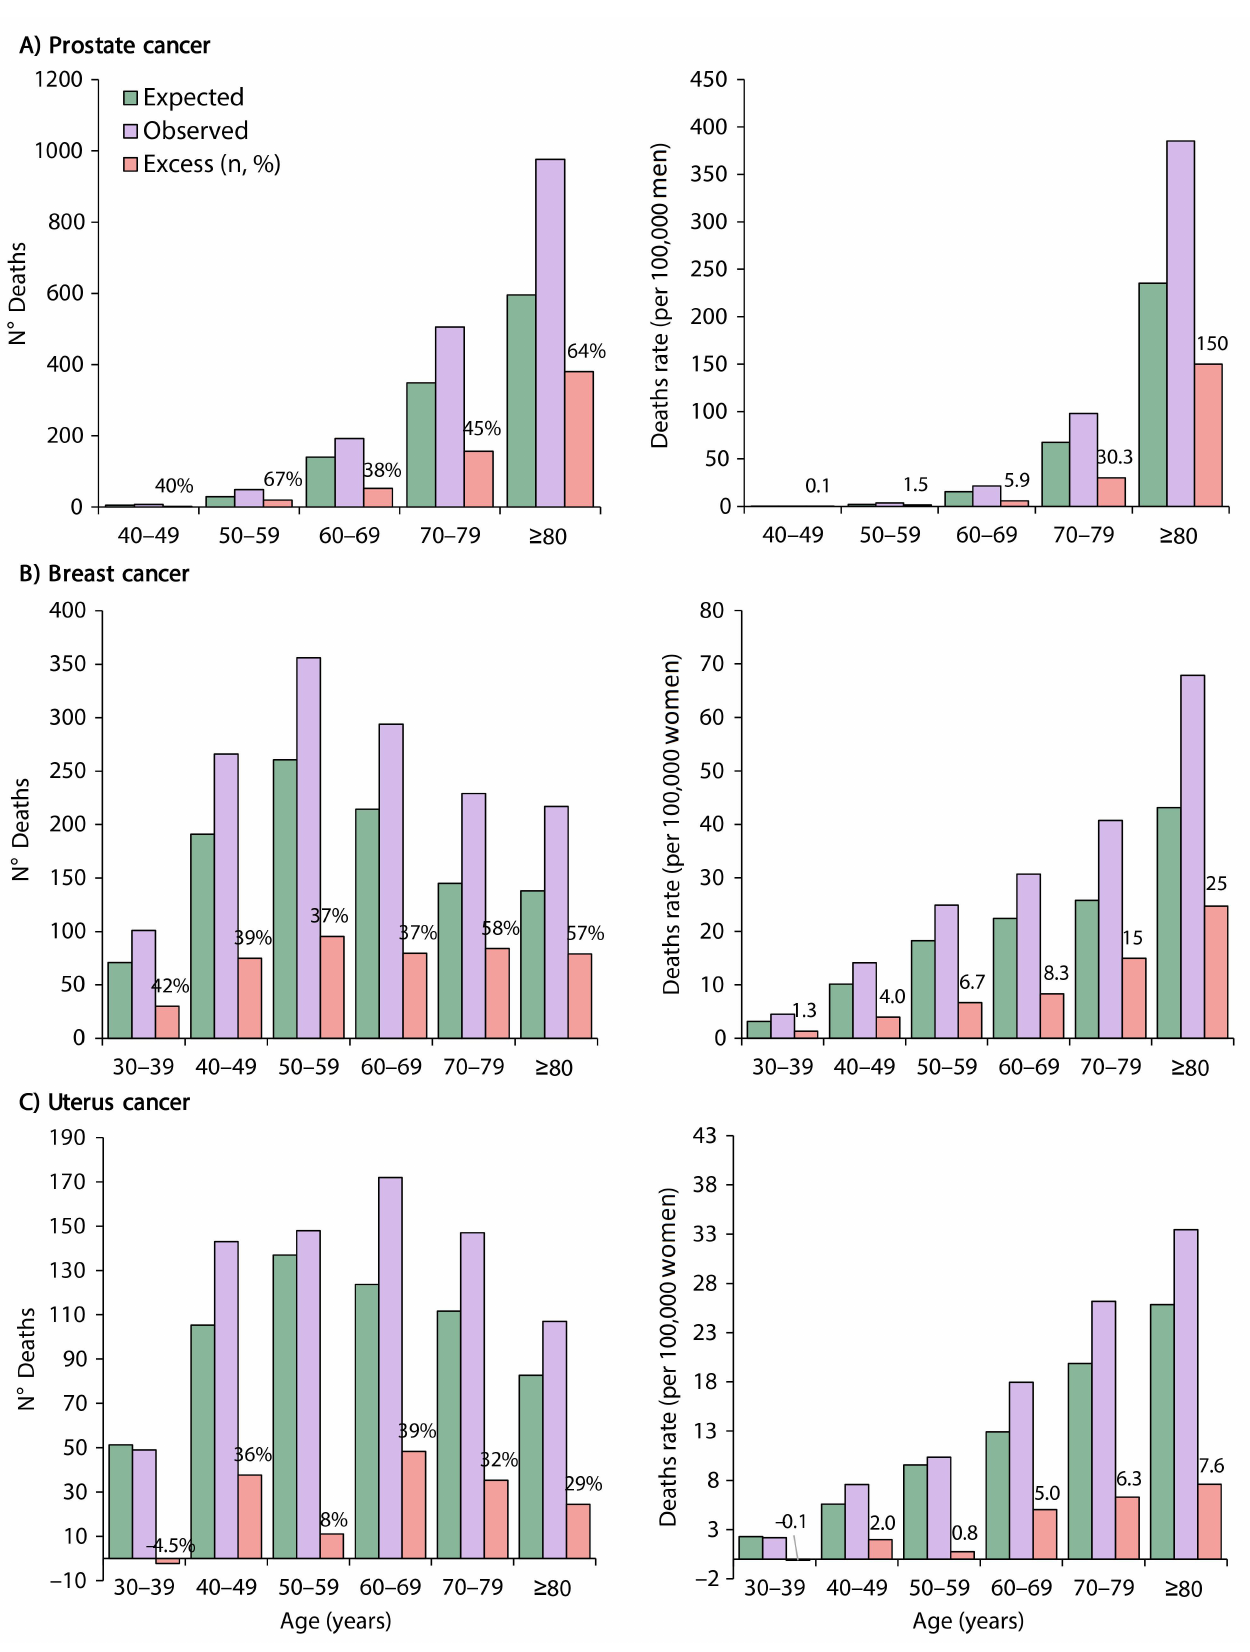
Figure 5. Deaths observed, deaths expected, and excess numbers of deaths and excess death rates